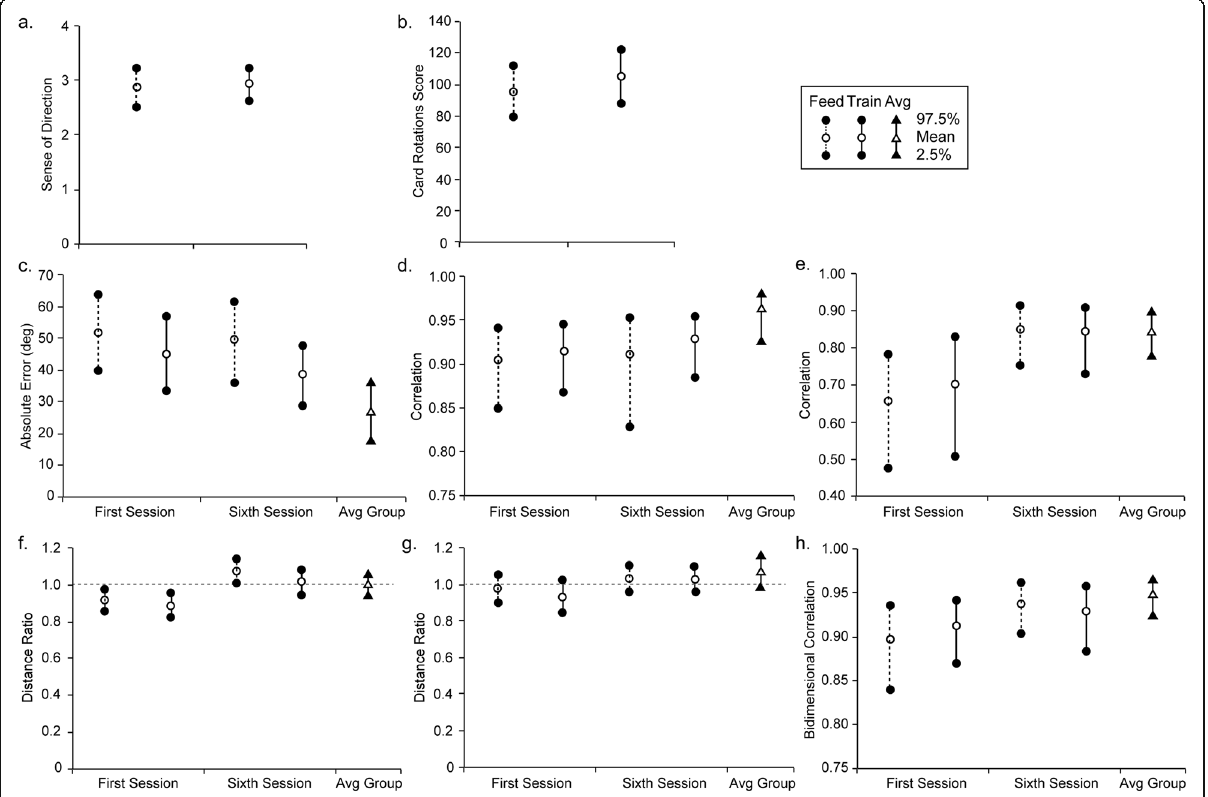
Fig. 7 Results of a Bayesian analysis of participants ’ attributes and performance: 95% credible intervals (circles represent participants with a poor sense of direction, dotted lines for the feedback-only condition and solid lines for the training condition, and triangles represent participants in the average group) for sense of direction ( a ), Card Rotations scores ( b ), direction estimates ( c ), distance correlations for route distances ( d ) and straight-line distances ( e ), distance ratios for route distances ( f ) and straight-line distances ( g ), and sketch maps ( h )